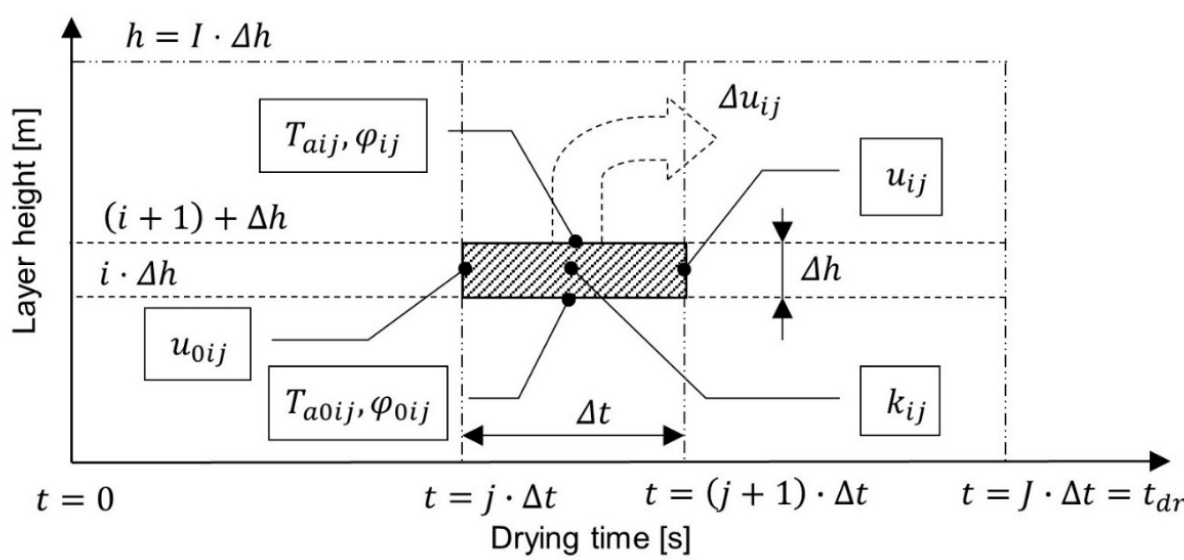
Figure 5. Schematic diagram of the drying model.